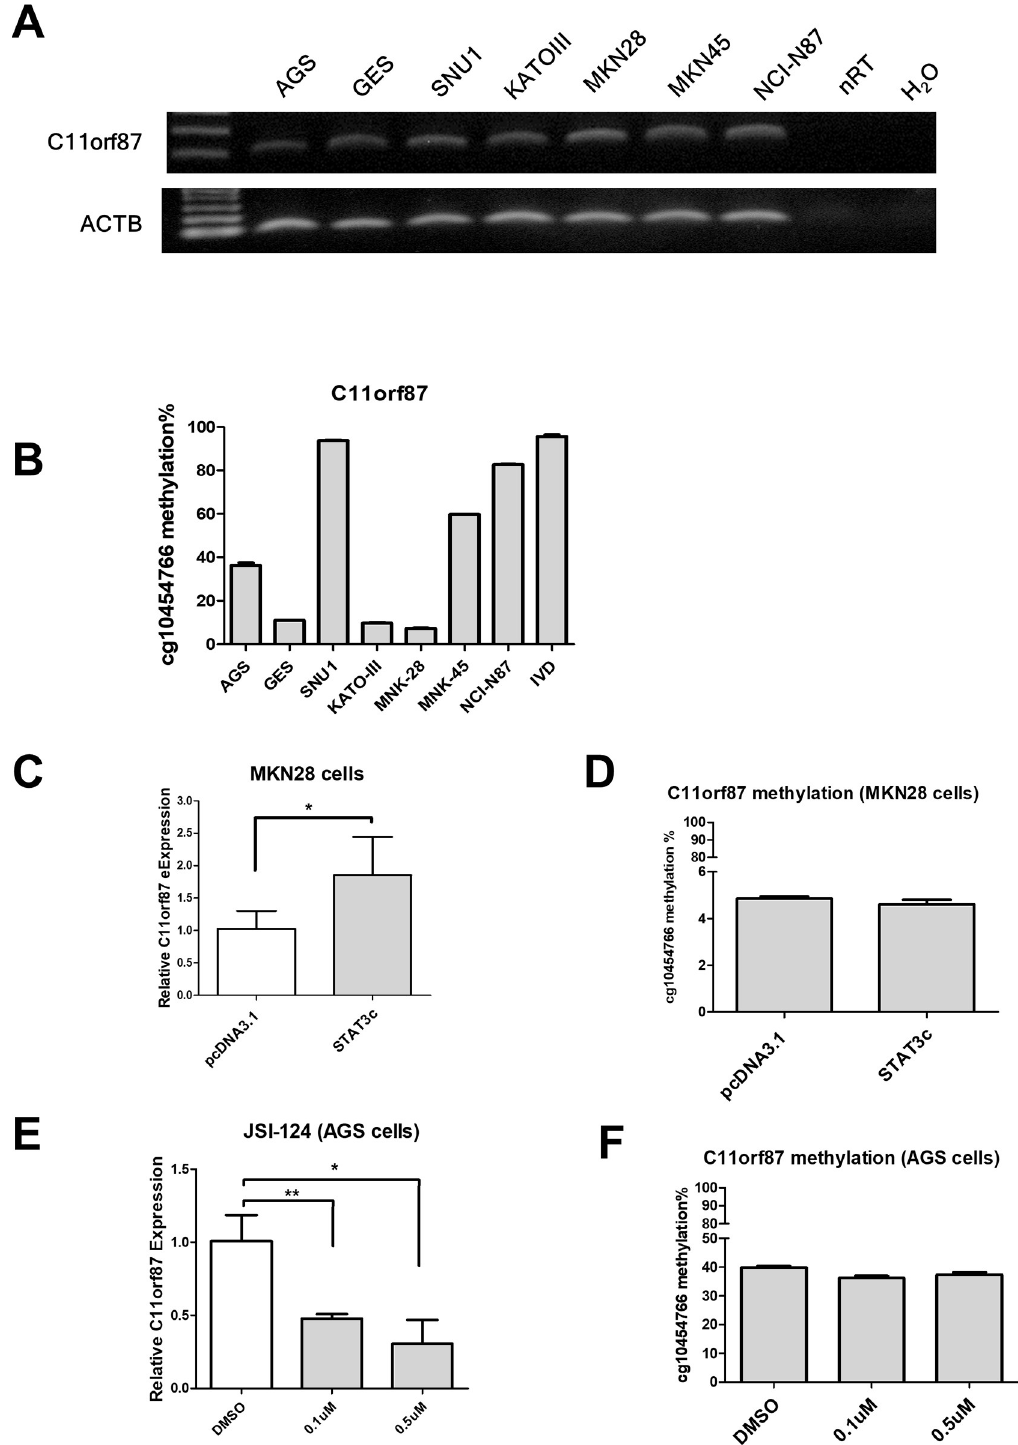
Fig 2. The expression and methylation of C11orf87 in gastric cancer cell lines. (A) Expression and (B) methylation of C11orf87 was determined by RT-PCR and bisulfite pyrosequencing, respectively in GC cell lines and an immortalized gastric epithelial cell lines, GES. MKN28 cells were transiently transfected with empty vector (pcDNA3.1) or vector expressing constitutive activated STAT3 mutant (STAT3c). C11orf87 expression and methylation were determined by (C) qRT-PCR and (D) bisulfite pyrosequencing, respectively. AGS gastric cancer cells were treated with DMSO or STAT3 inhibitor (JSI-124) for